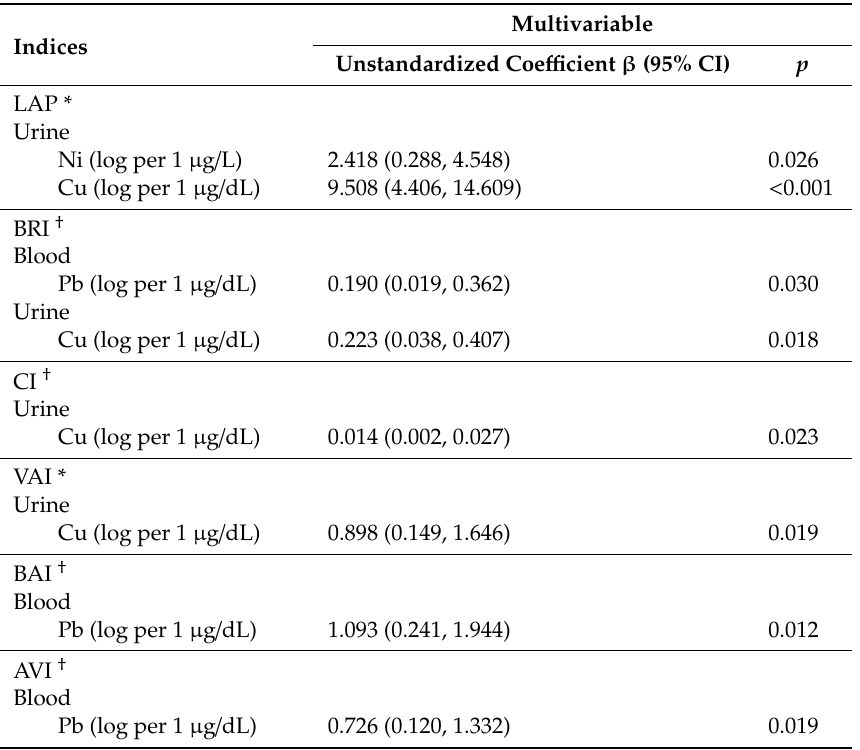
Table4. Associationofheavymetalswithdi ff